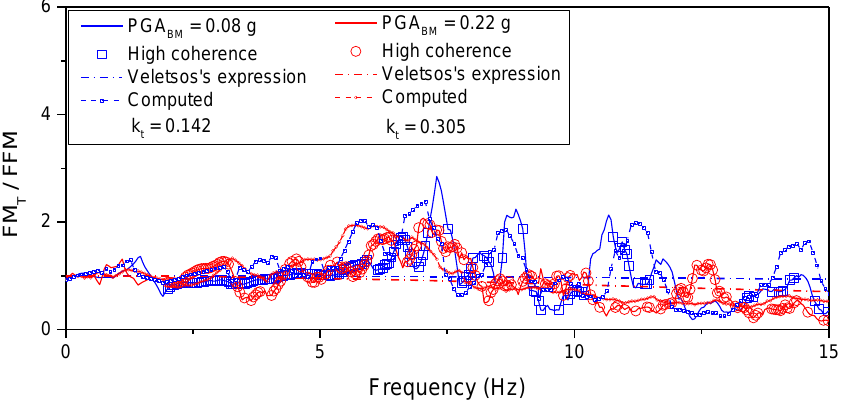
Figure 9. Translational transfer function between FM and FFM for the S1 structure at two levels of peak acceleration of the base motion (PGA BM ).